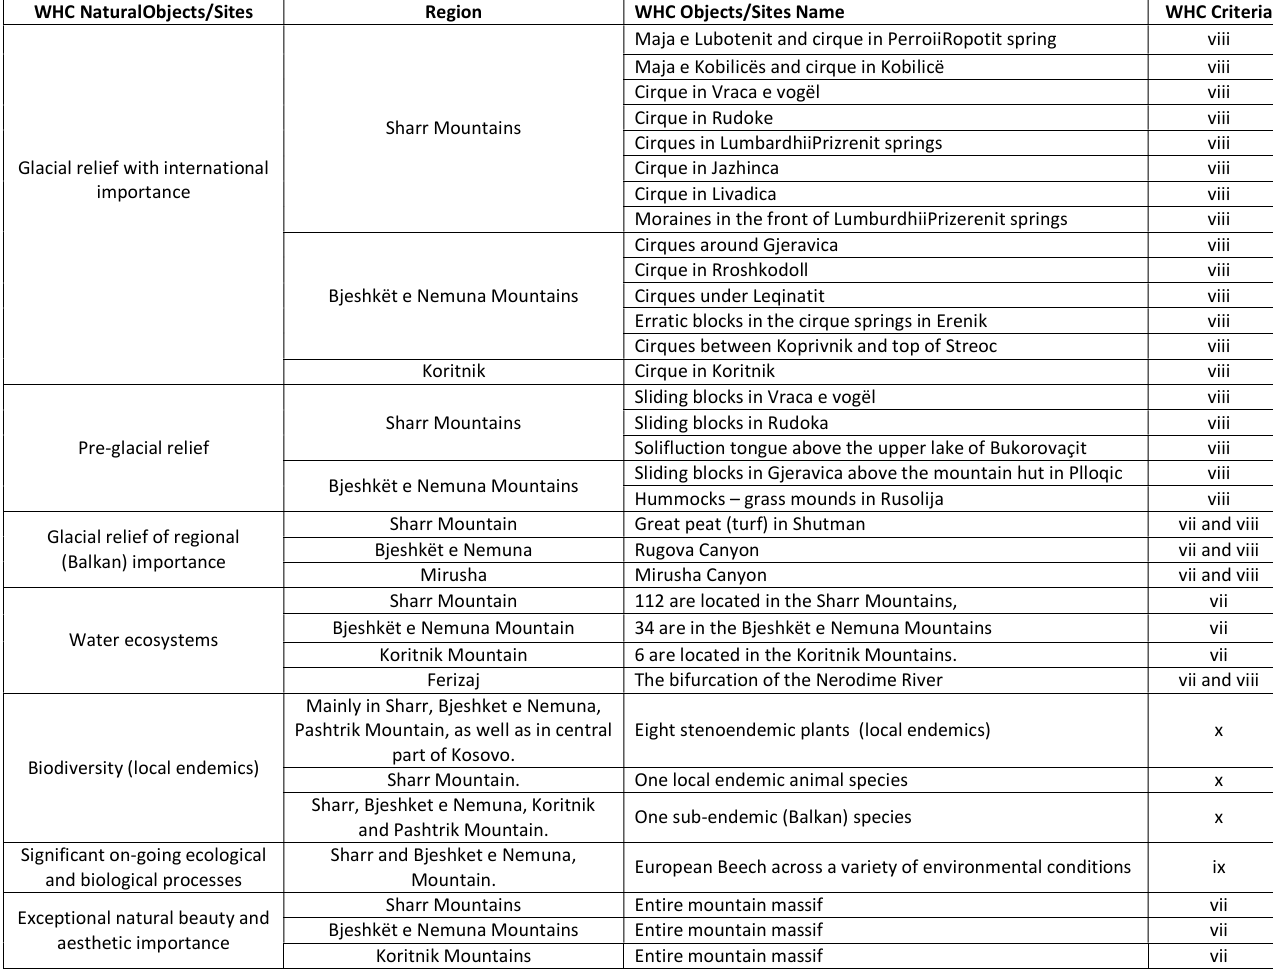
Table 1: Natural heritage values in Kosovo, according criteria vii-x of the World Heritage Convention (WHC)